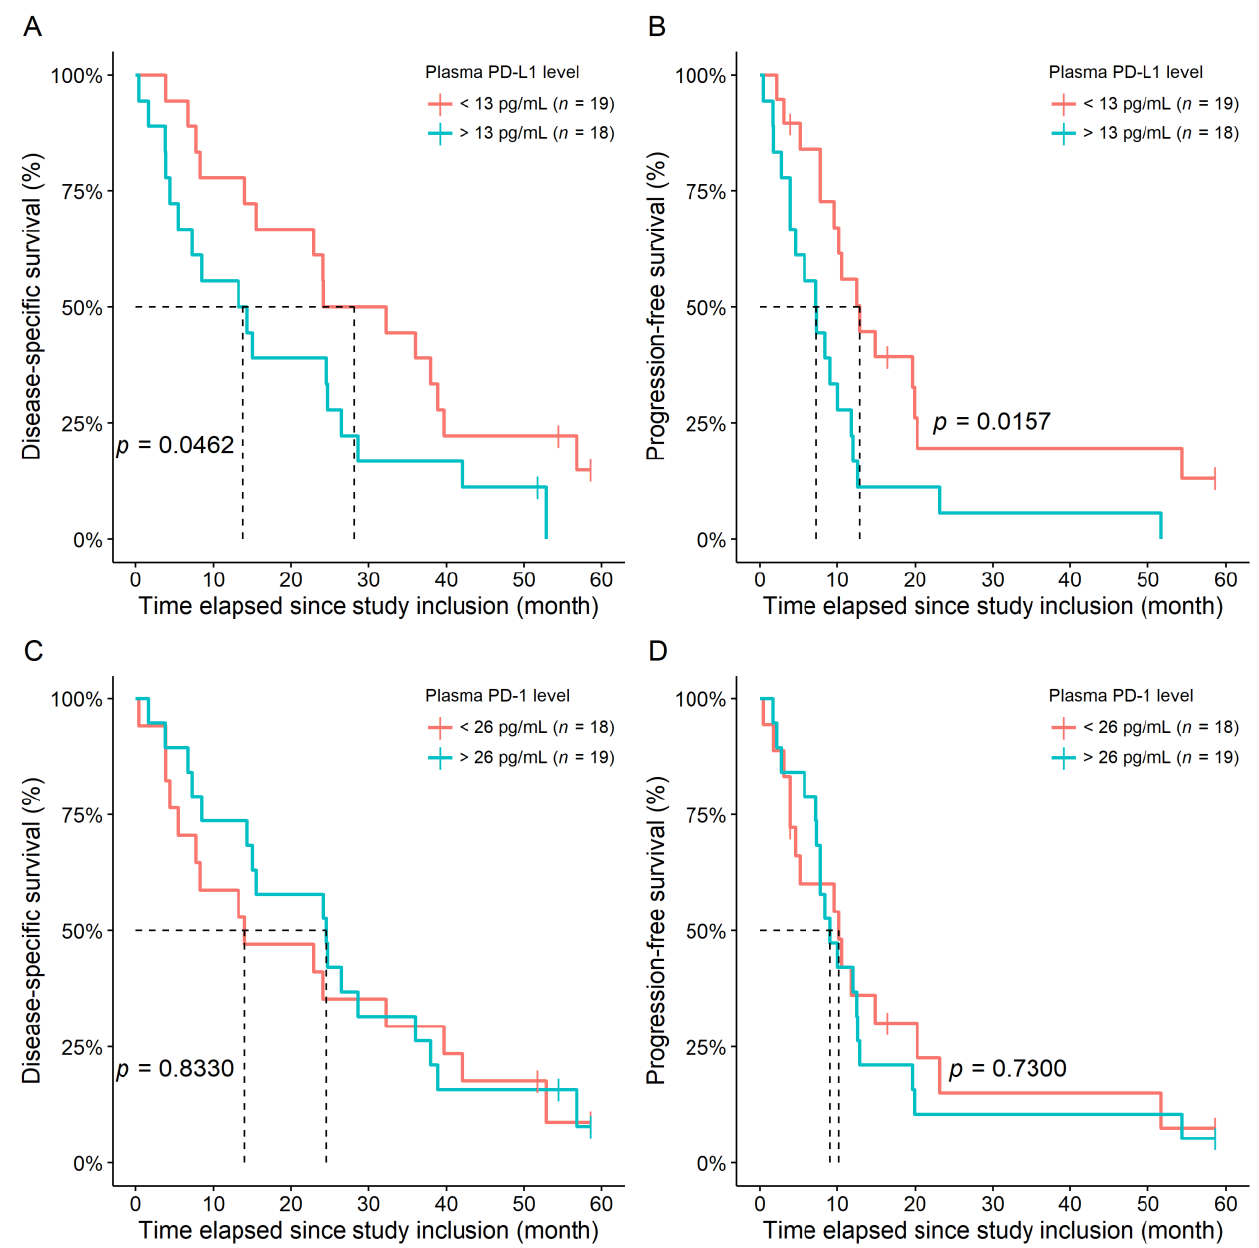
Figure 4. Disease-specific ( A , C ) and progression-free ( B , D ) survival differences between the high and low PD-L1 ( A , B ) and the high and low PD-1 ( C , D ) groups. PD-1: plasma programmed cell death protein 1; PD-L1: programmed death-ligand 1.